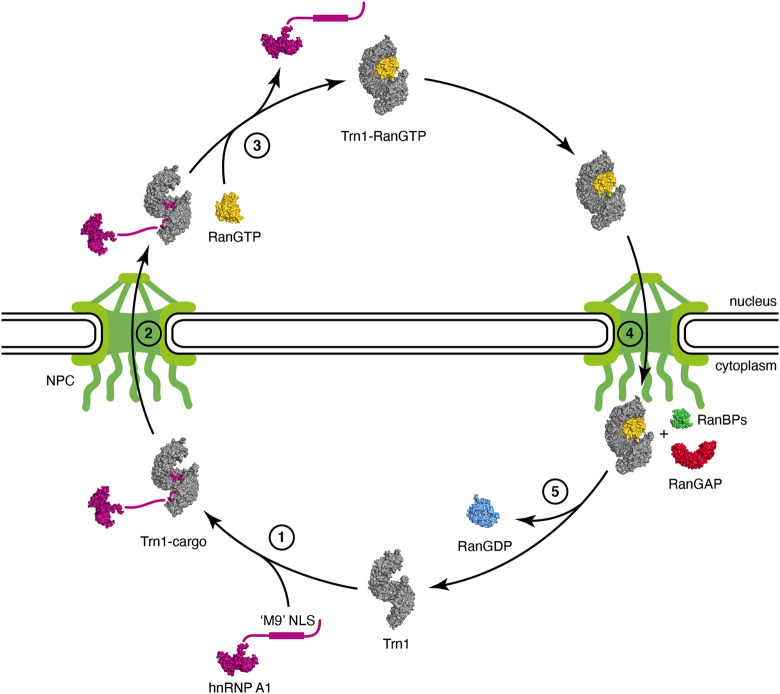
Nuclear import cycle of Transportin-1. (step 1) Trn1 associates with its cargo via the NLS in the cytoplasm [free Trn1 in gray: PDB code 2QMR (Cansizoglu and Chook, 2007); hnRNP A1 cargo with its unstructured ‘M9’ NLS in purple: PDB code 2LYV (Barraud and Allain, 2013); Trn1-cargo in gray and purple: PDB code 2H4M (Lee et al., 2006)]. (step 2) Trn1 associated with its cargo transits towards and passes through the NPC. The NPC, with the nuclear basket and the cytoplasmic filaments, is schematically represented in green. (step 3) Trn1 associated with its cargo binds to RanGTP in the nucleus, which triggers cargo release [RanGTP in yellow: PDB code 1RRP (Vetter et al., 1999); Trn1-RanGTP in gray and yellow: PDB code 1QBK (Chook and Blobel, 1999)]. (step 4) Trn1 associated with RanGTP transits towards and passes through the NPC. (step 5) At the cytoplasmic face of the NPC, RanGTP is hydrolyzed and released from Trn1 upon the combined action of RanBPs and RanGAP (RanBP1 in green and RanGAP in red: PDB code 1K5D (Seewald et al., 2002); RanGDP in blue: PDB code 1BYU (Stewart et al., 1998)]. Trn1 is free again in the cytoplasm and ready for another import cycle.